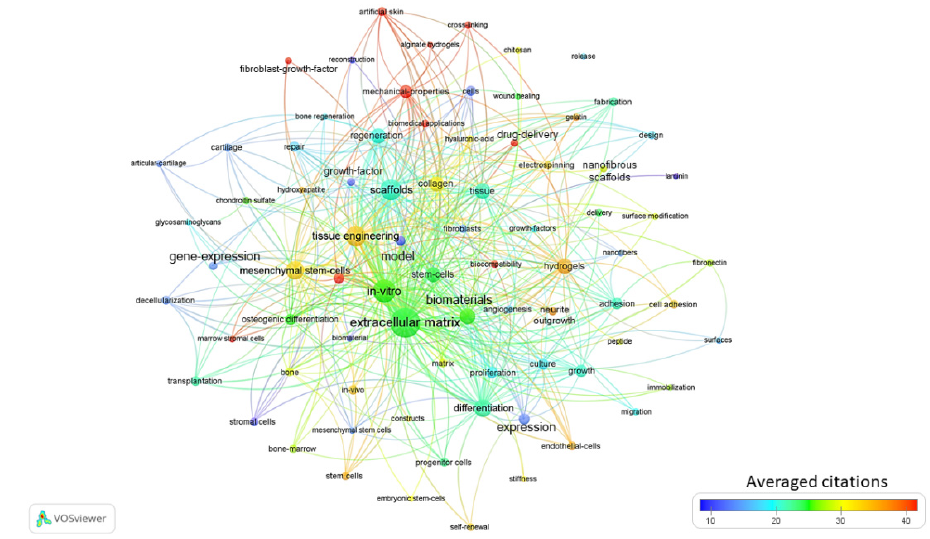
Figure 3. Term map for years 2010 through 2019. Term map showing the visualization of 79 terms. Table S9 contains all the terms visualized with their respective occurrence frequencies and averaged citations.